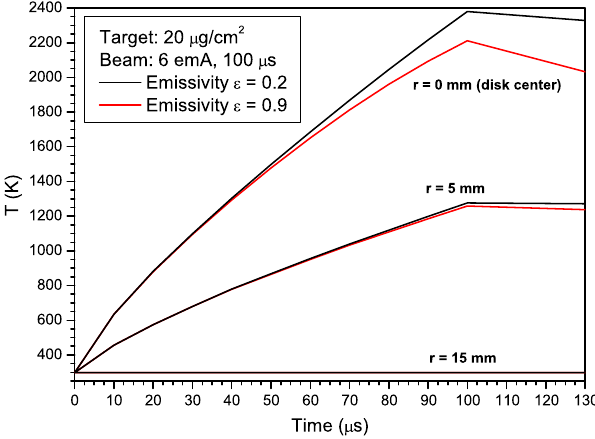
FIG. 5. Temperature vs time using ϵ ¼ 0 . 2 and 0.9 for the case in Fig. 3.